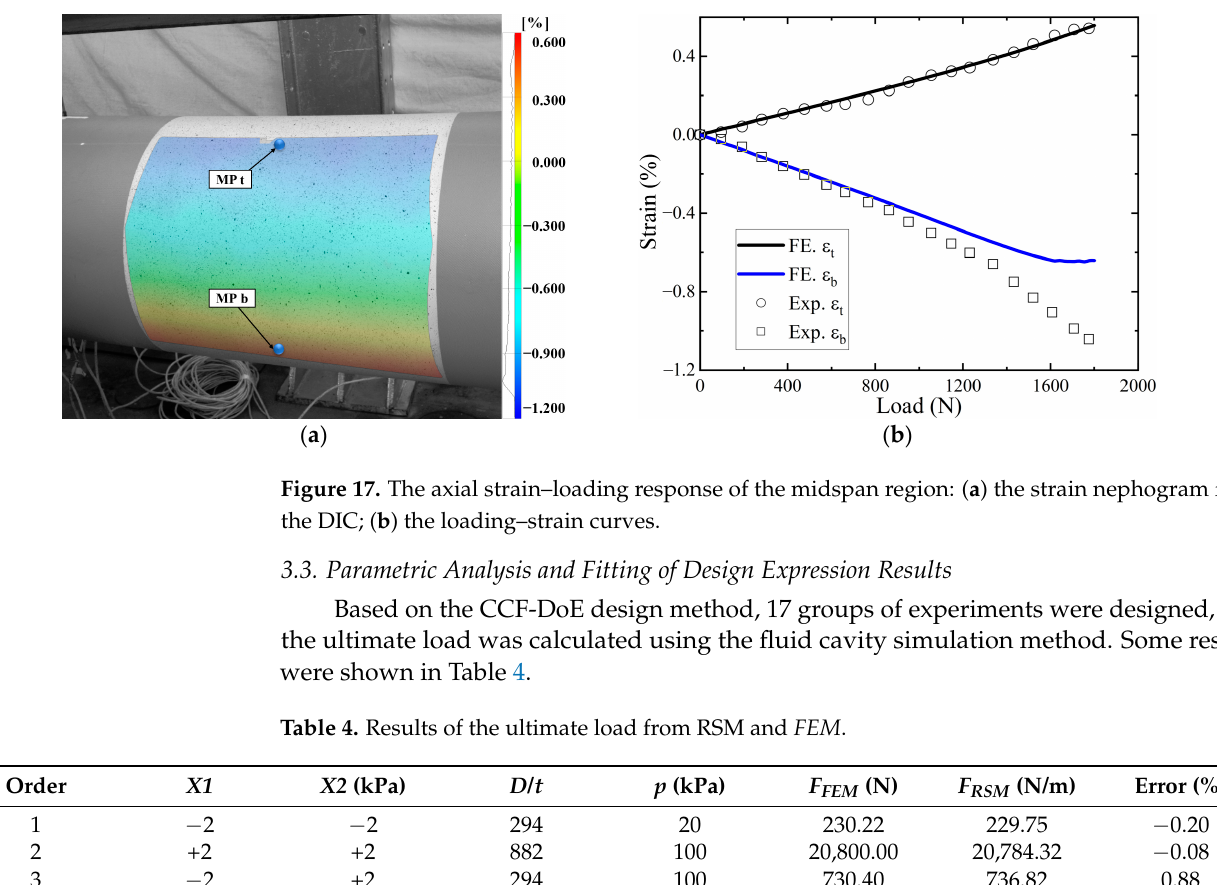
Table 4. Results of the ultimate load from RSM and FEM